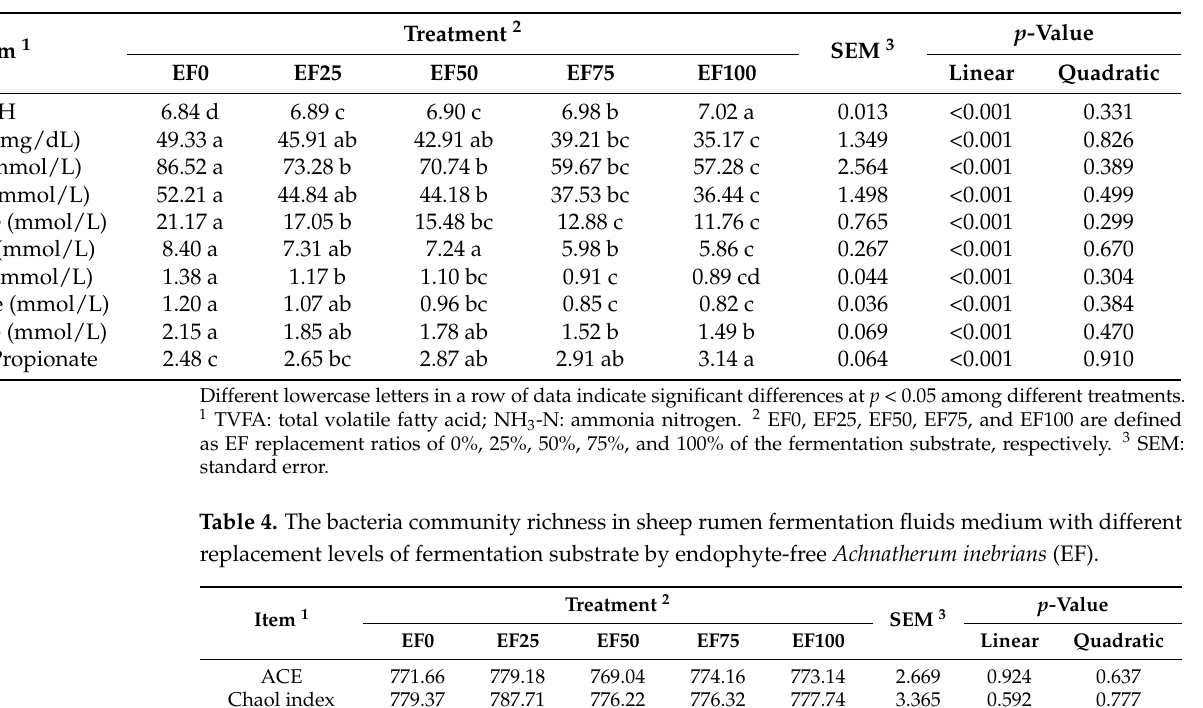
Table 3. Effect of different replacement proportions of endophyte-free Achnatherum inebrians (EF) on the pH, fermentation parameters and NH 3 -N.